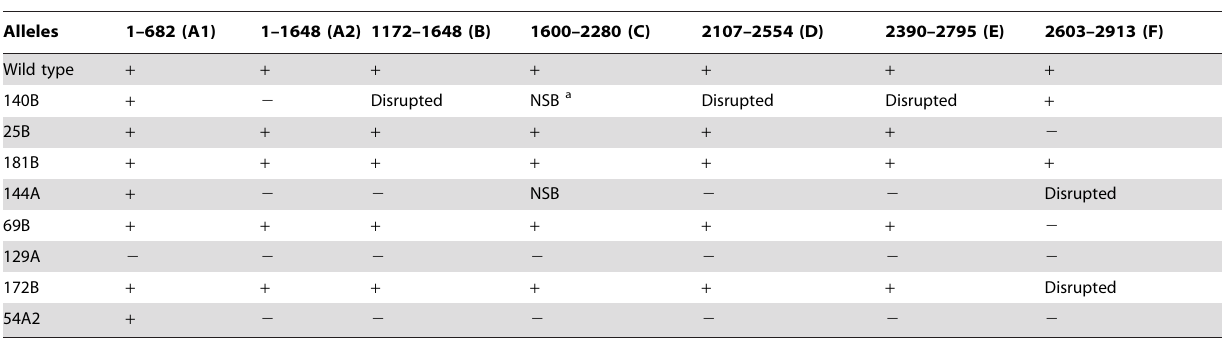
Table 2. Deletion analysis of Ntl alleles.